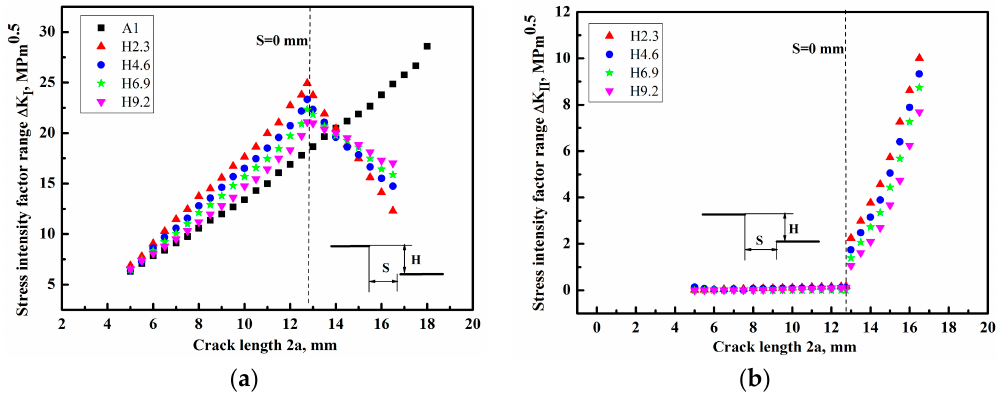
Figure 5. The stress intensity factor range ( a ) Δ K I and ( b ) Δ K II changing with the crack growth length 2a.